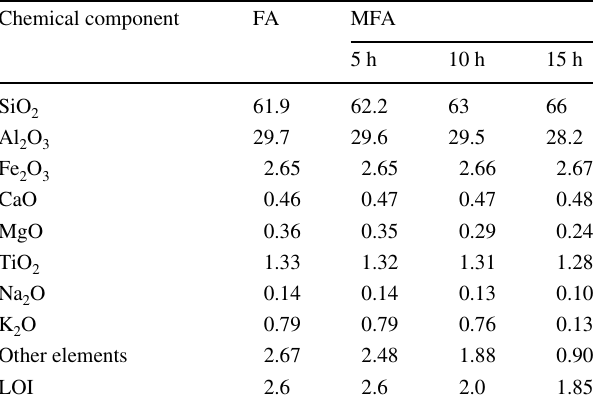
Table 8 Effect of Mechanical activation on composition of fly ash (Sharma et al.